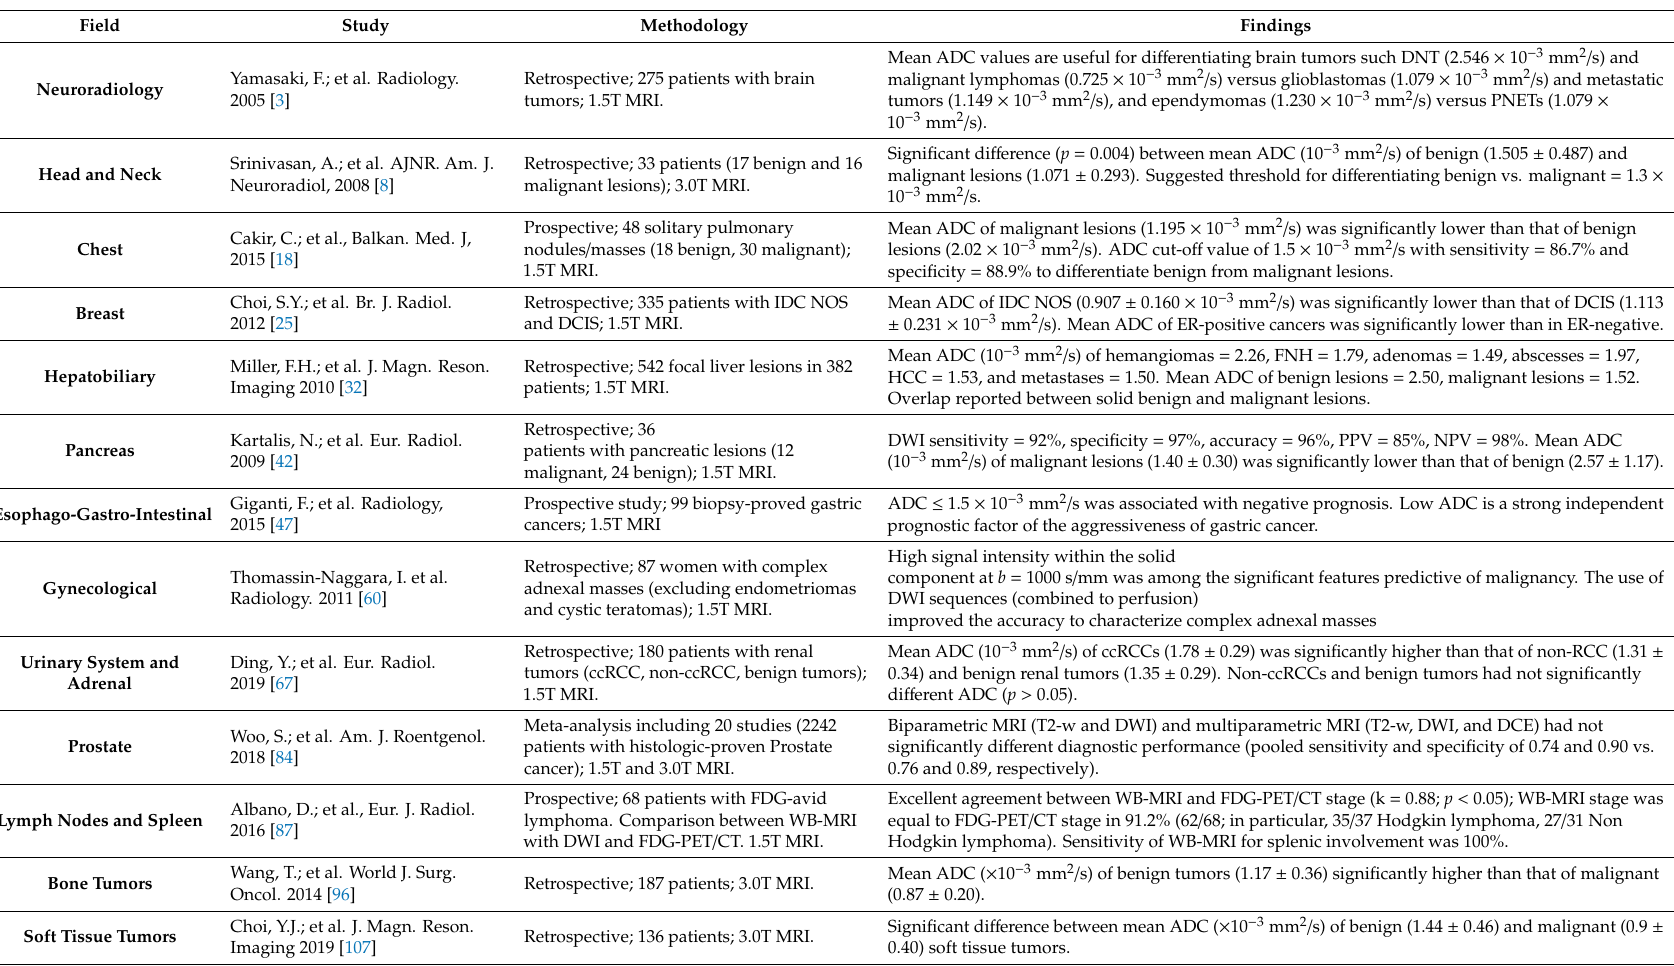
Table 1. Synoptic table summarizing the main papers discussed in the review and their